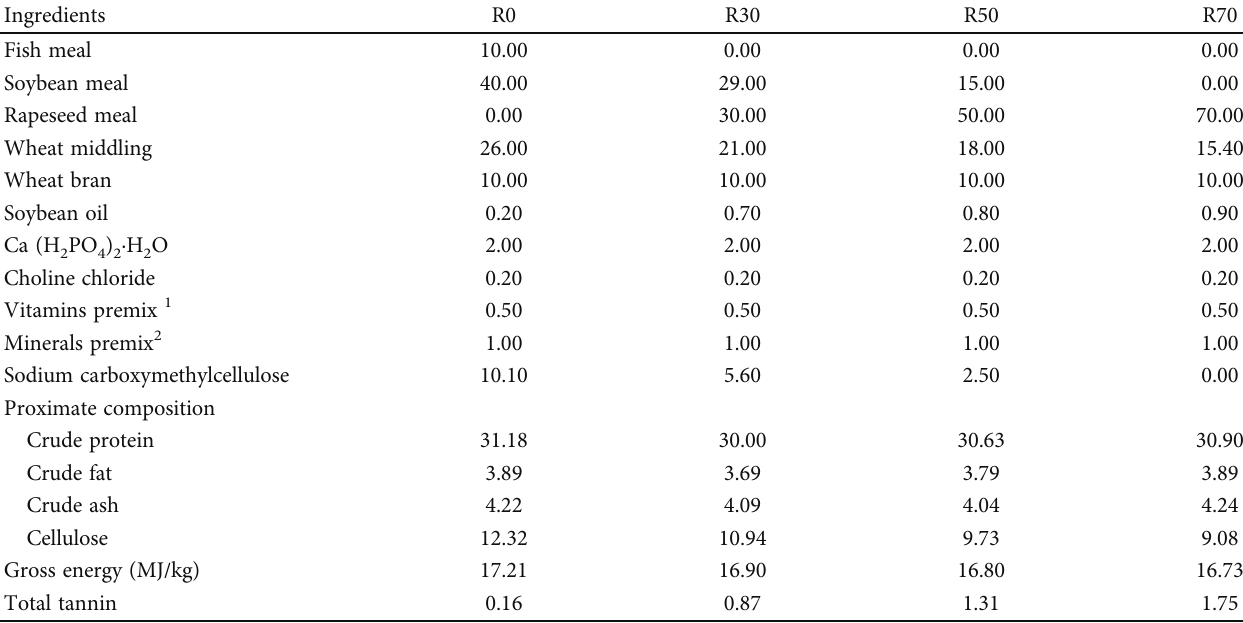
Table 2: Composition and nutrient levels of practical diets (air dry basis)